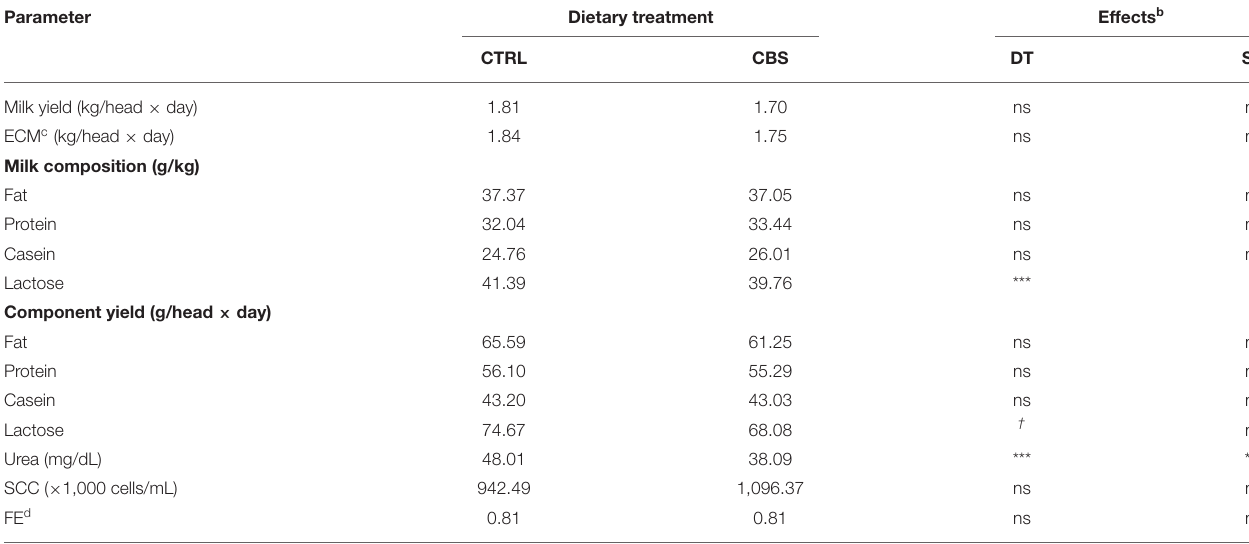
TABLE 3 | Milk yield, milk main constituents, and somatic cell count of milk from goats fed the control (CTRL) and cocoa bean shell (CBS) diets a . Parameter Dietary treatment Effects